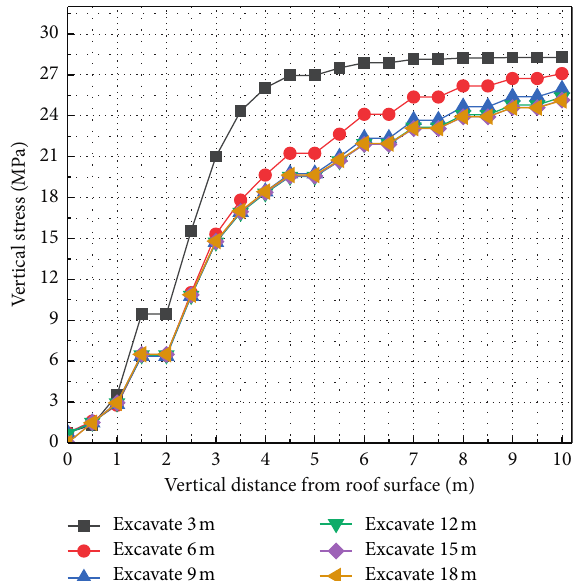
Figure 6: Vertical stress distribution under different excavation distance.